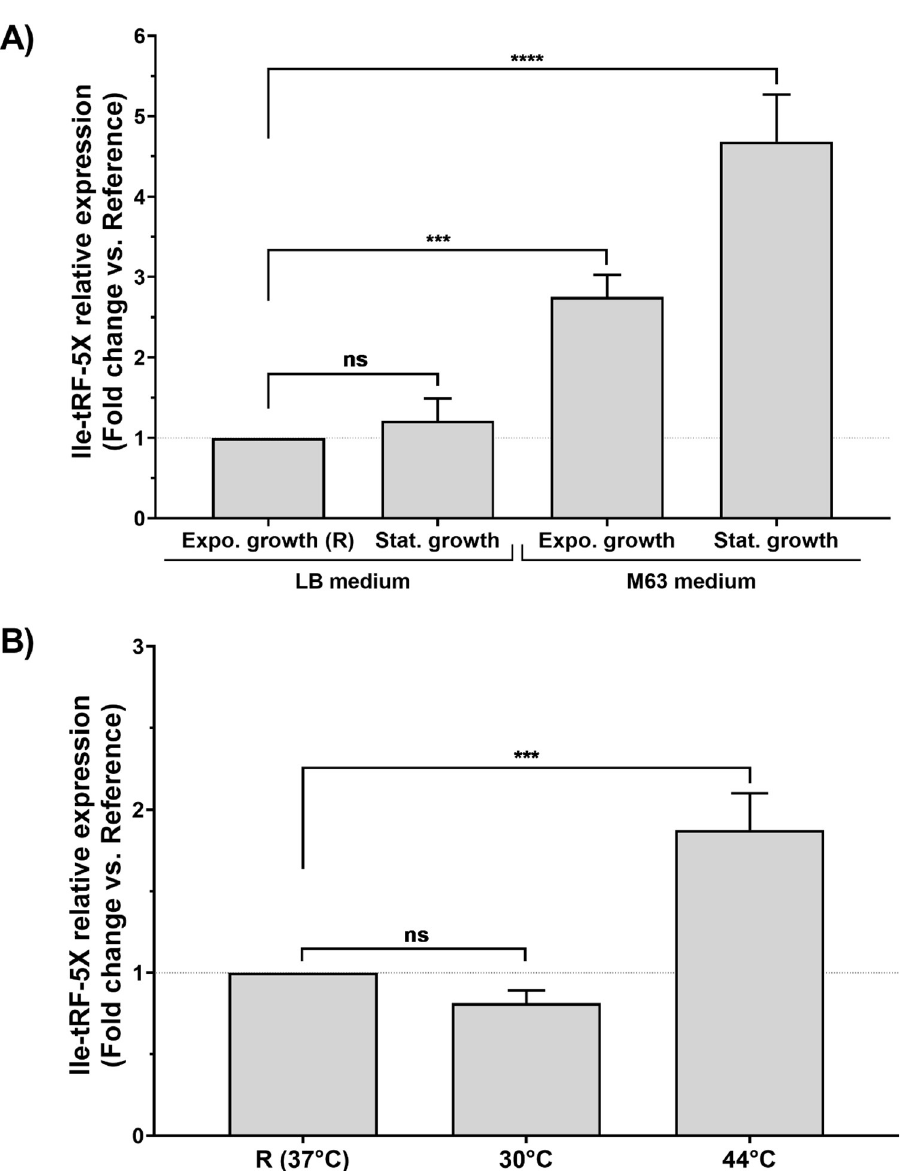
Fig 2. Bacterial Ile-tRF-5X levels under different growth and temperature conditions. ( A ) E . coli MG1655 bacteria were grown at 37˚C, and the level of Ile-tRF-5X was monitored during the exponential and stationary phases of growth in either complete (rich) LB or minimal M63 medium. ( B ) E . coli MG1655 bacteria were grown in LB medium, and the level of Ile-tRF-5X was monitored during the exponential phase at 30, 37 and or 44˚C (for details, see S1 Table and S2 Fig ). The level of Ile-tRF-5X was measured by LNA RT-qPCR. A spike-in (UniSp6) and reference genes (23S and/or 16S) were used as control and for normalization. The results are reported in fold change compared to the